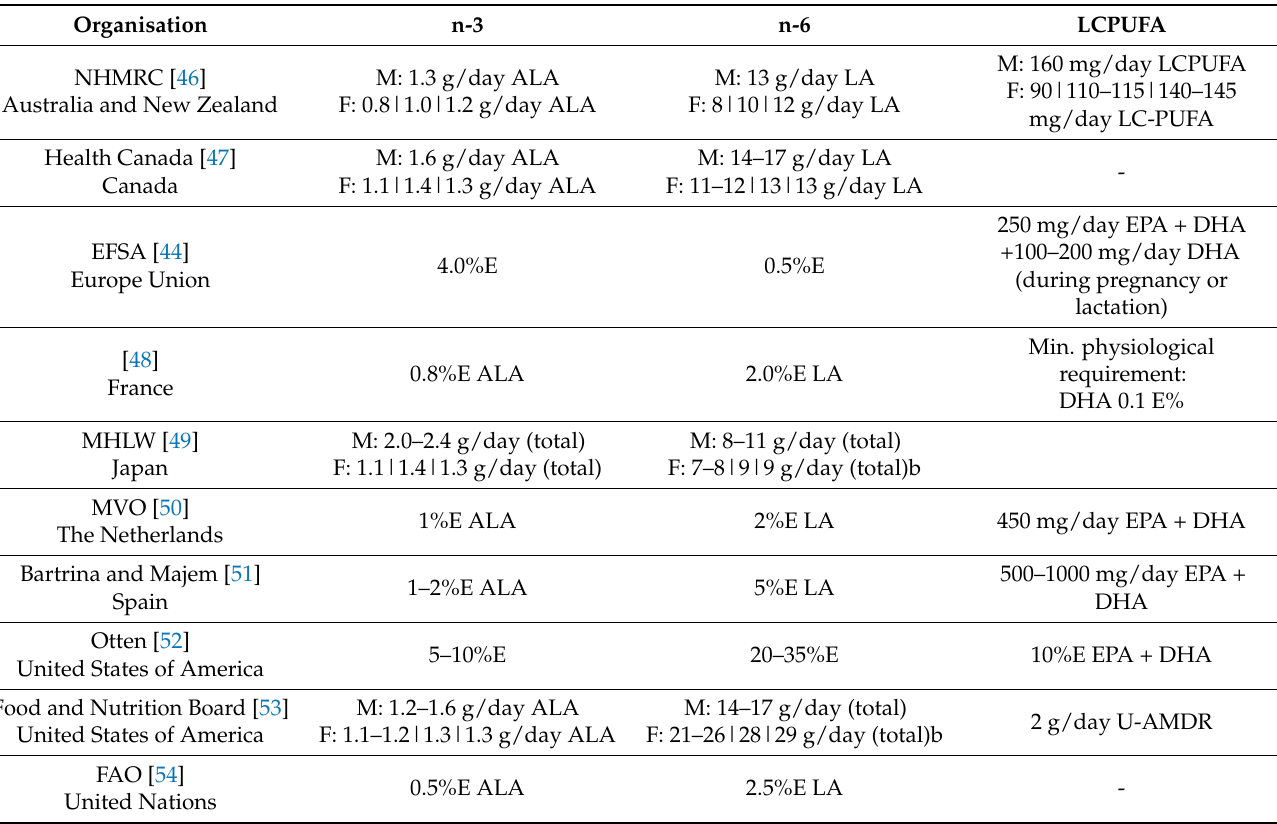
Table 3. Examples of omega-3 (n-3), omega-6 (n-6), and total long chain polyunsaturated fatty acid (LCPUFA) dietary recommendations for a healthy adult (18 years and older). Abbreviations include male (M); female (F); alpha-linolenic acid (ALA); linoleic acid (LA); percentage total energy (%E); eicosapentaenoic acid (EPA); docosahexaenoic acid (DHA); and acceptable macronutrient distribution range (AMDR). Please note that for female adults, recommendations are categorised using physiological status (as everyday, during pregnancy and during